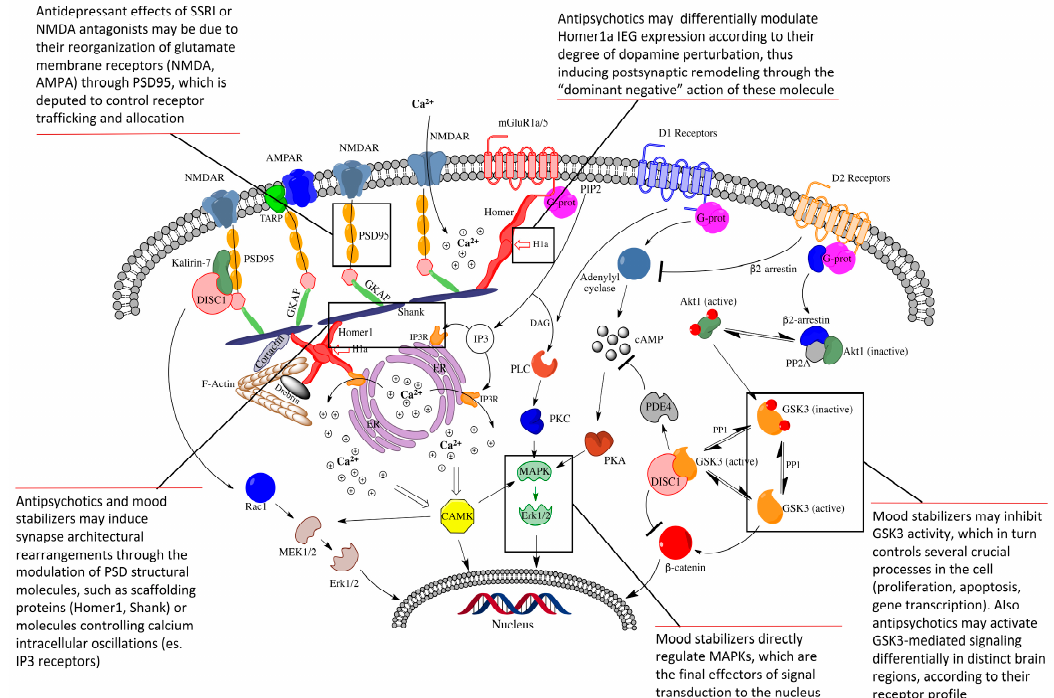
Figure 1. Schematic representation of how postsynaptic density (PSD) proteins elaborate and integrate multiple transductional pathways starting at main dopamine and glutamate membrane receptors. Scaffolding proteins (Homer, Shank, PSD-95) physically connect receptors, linking them to intracellular calcium stores. Transductional pathways activated by dopamine receptors closely interconnect with glutamatergic ones via key PSD proteins, such as GSK3, which elaborates and regulates neuronal survival and differentiation. All transductional pathways route receptors signaling to appropriate nuclear targets via specific effectors, such as CaMK, MAPKs, or Erk, in order to finely modulate long-term activity-dependent neuronal rearrangements. The call-outs describe the impact on some crucial PSD molecules by psychopharmacologic drugs, as discussed in the text. NMDAR , N -methyl- D -aspartate glutamate receptor; AMPAR , α -amino-3-hydroxy-5-methyl-4-isoxazolepropionic acid glutamate receptor; mGluR1a/5 , metabotropic glutamate receptor type 1a/5; TARP , transmembrane AMPA receptors regulating protein or stargazin; PSD-95 , postsynaptic density protein 95kD; DISC1 , disrupted in schizophrenia 1; GSK3 , glycogen synthase kinase 3; PDE4 , phosphodiesterase 4; GKAP , guanylate kinase associated protein; H1a , Homer1a immediate-early inducible protein; PIP2 , phosphatydilinositol bisphosphate; DAG , diacylglycerol; IP3 , inositol 1,4,5-trisphosphate; cAMP , cyclic adenosine monophosphate; ER , endoplasmic reticulum; PLC , phospholipase C; PKC , protein kinase C; PKA , protein kinase A; CAMK , calcium-calmodulin regulated kinase; MAPKs , mitogen-activated protein kinases; Erk , extracellular signal-regulated kinase; MEK , MAPK/Erk kinase; and Rac1 , Ras-related C3 botulinum toxin substrate 1.